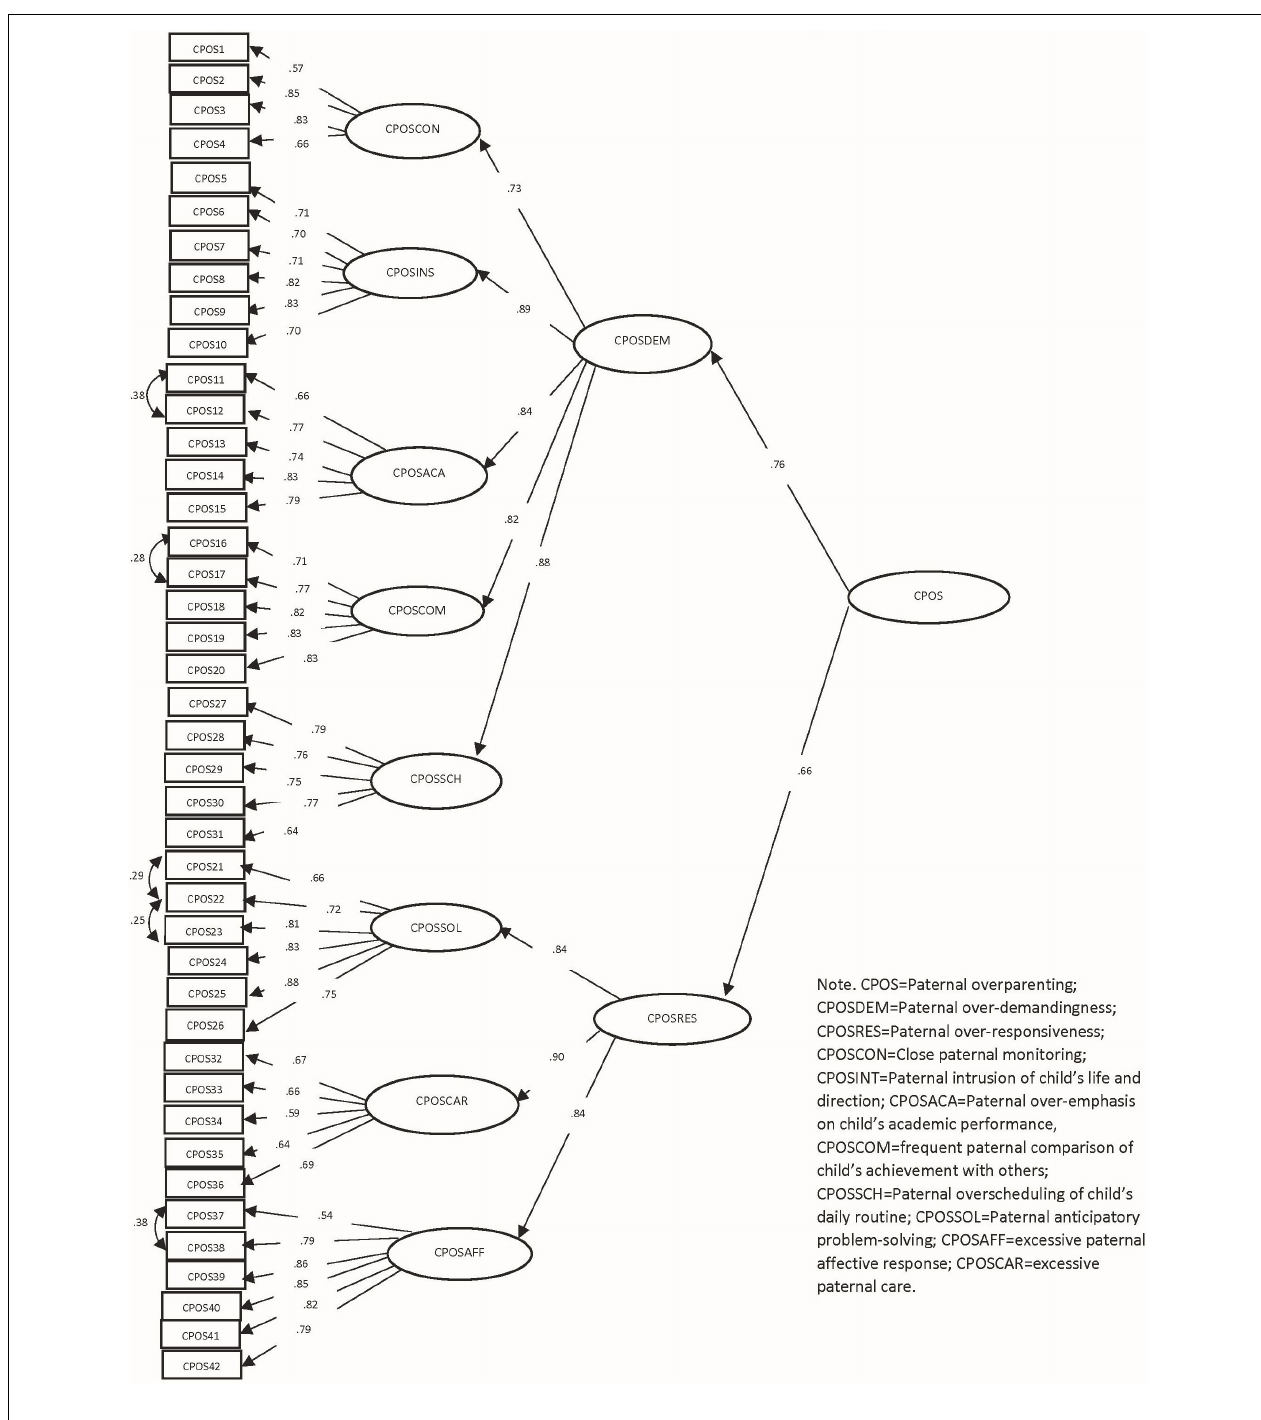
FIGURE 1 | Factor structure and standardized coefficients of chinese Paternal Overparenting